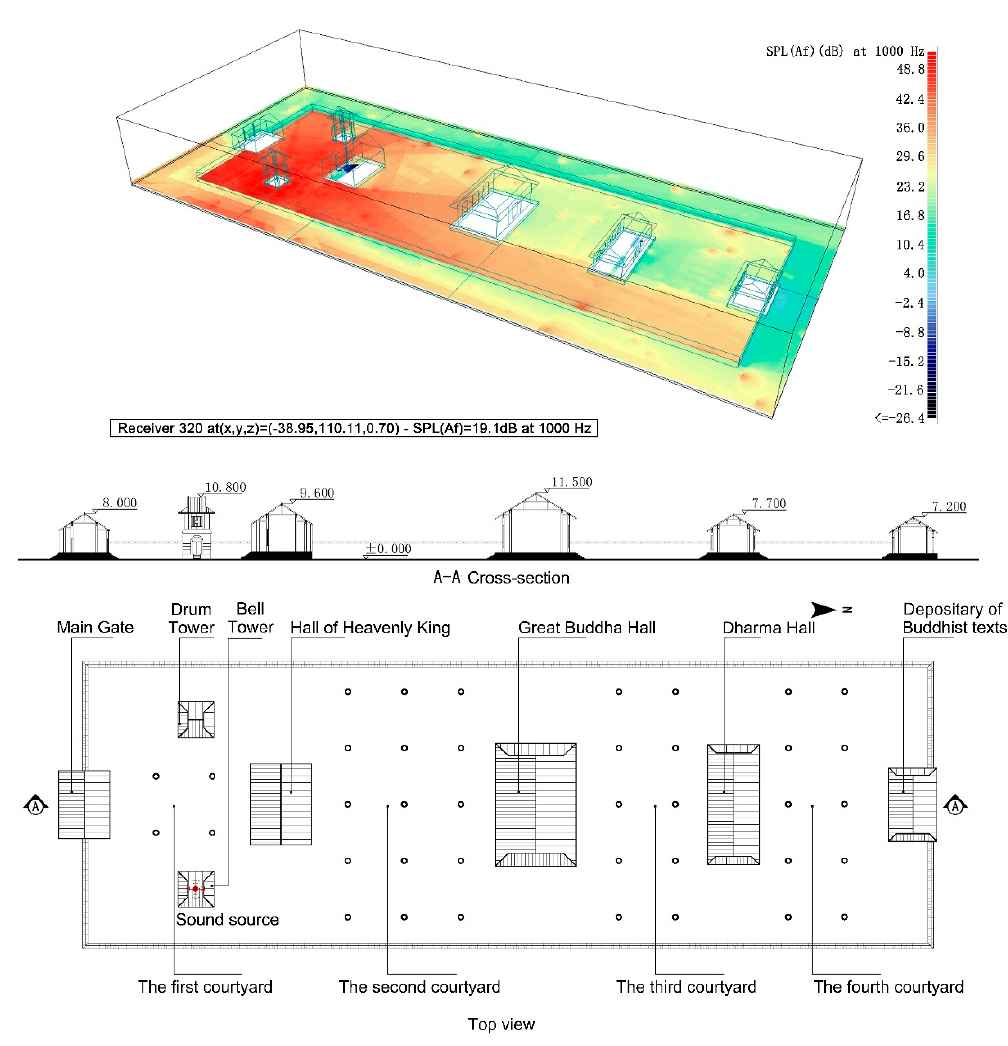
Figure 2. Acoustic model diagram, top view, and cross-sectional view of the Buddhist temple (the dots in the courtyard plane represent the positions of sound receivers).